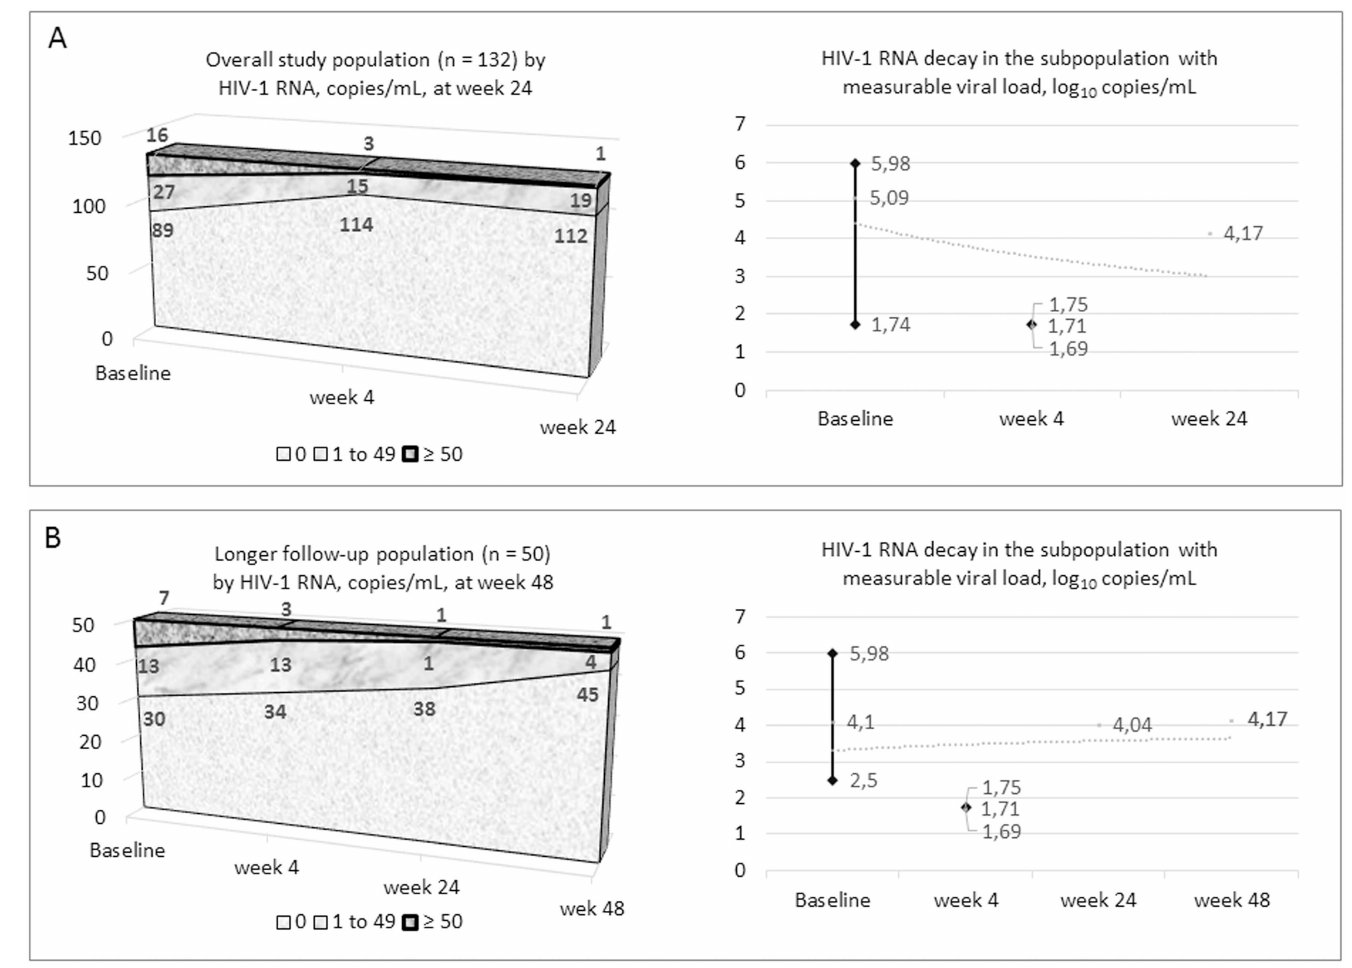
Fig 2. Virologic response in the global population (A) and in the subgroup that has reached week 48 (B). Proportion of viremia ranks over time, and medianviral decay (range) and trend in viremic